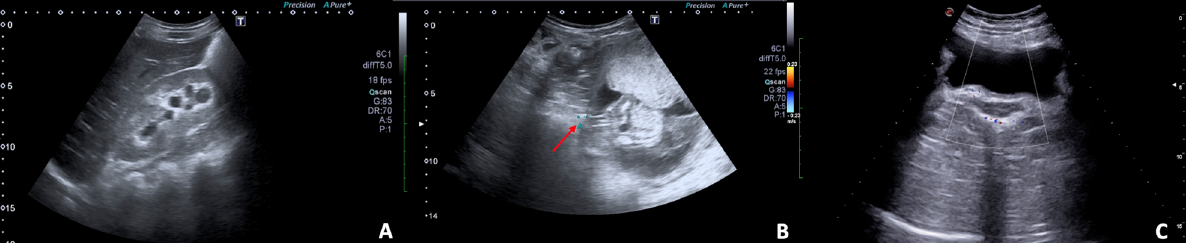
Figure 8. US B-mode ( A , B ) and Colour Doppler ( C ) scans in pregnant woman with right flank pain and nausea. ( A ) Collecting system of the right kidney is dilated with evidence ( B ) of a calculus (arrow) in the middle tract of the lumbar ureter resulting in complete urinary obstruction and mild hydronephrosis; ( C ) no right ureteral jet is detected on Colour-Doppler. When symptoms continue despite conservative management or when US is negative, MR urography is the second-level imaging technique [16]. Stones appear as signal voids